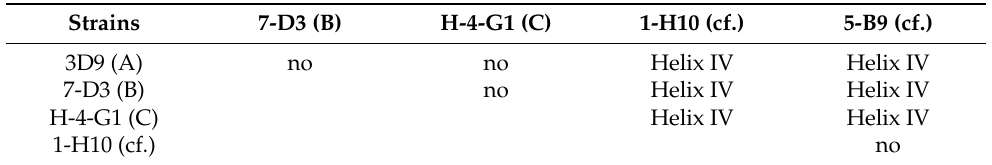
Table 2. Presence and location of compensatory base change (CBC) among Azadinium spinosum (ribotype A, B, and C) and/or Az. cf. spinosum (cf.) strains.